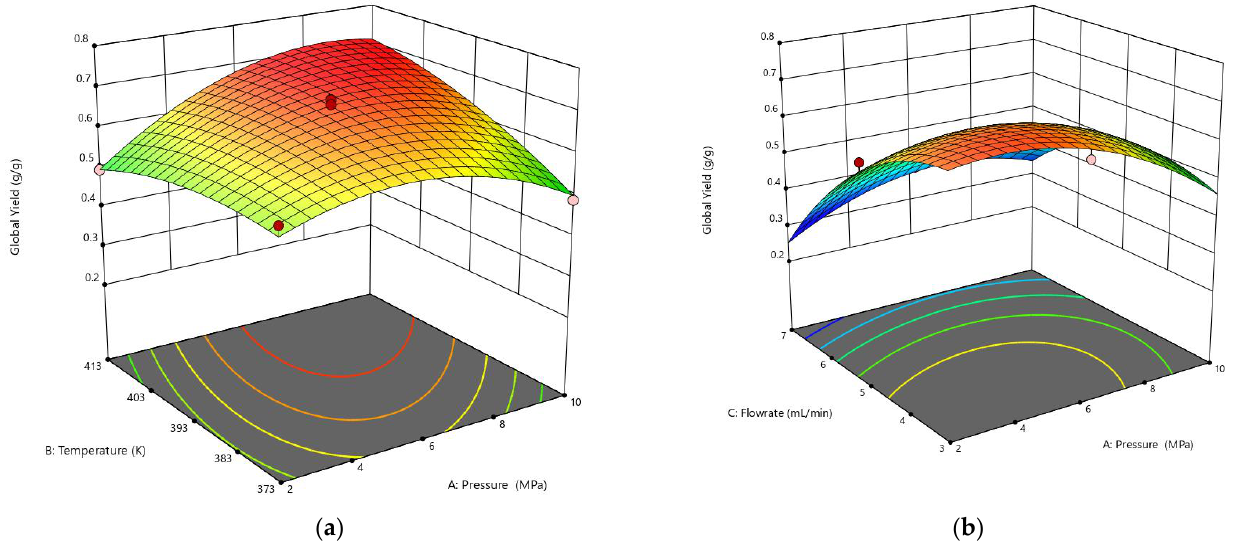
Figure 3. The 3D response of the effects of variables on the yield (g/g) at ( a ) a constant flow rate of 5 mL/min and ( b ) a temperature of 393 K.